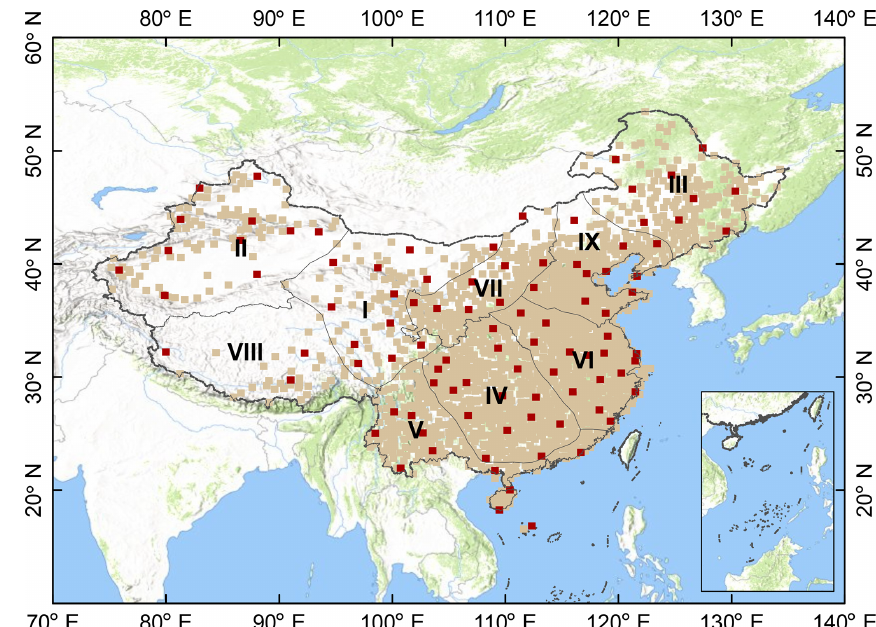
Figure 1. The 2400 sunshine duration (SunDu) merging sites are shown as light brown points, and 97 independent validation sites, including R s direct measurements and SunDu-derived R s measurements, are shown as brown red points. The whole region is classified into nine subregions (I to IX) by the K -mean cluster method based on geographic locations and multiyear mean R s using 97 R s direct observation sites. The base hillshade map was produced by an elevation map of the study area using the global digital elevation model (DEM) derived from the Shuttle Radar Topography Mission 30 (SRTM30)